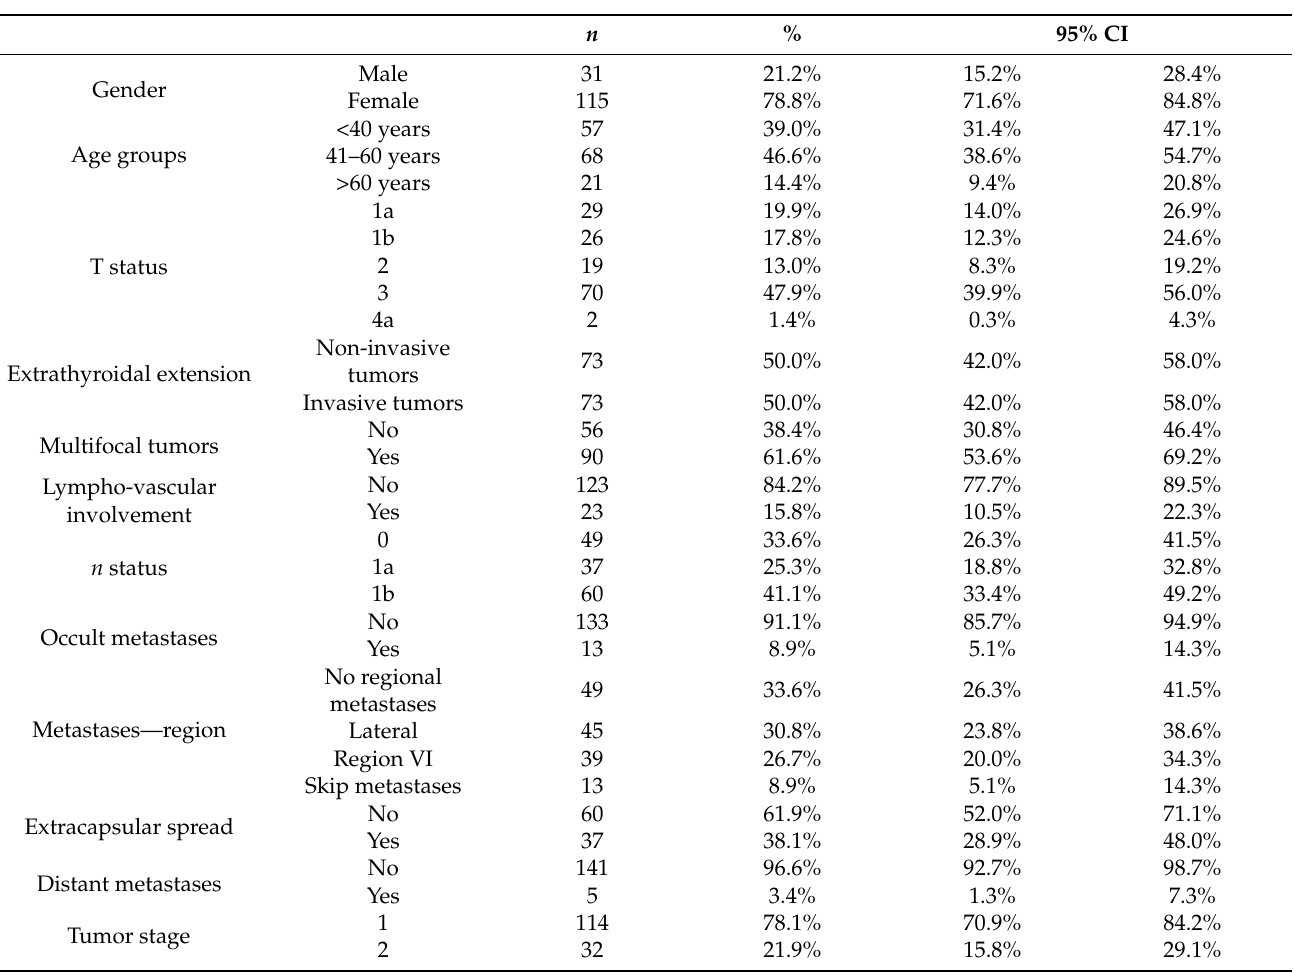
Table 1. Descriptive statistics of clinical and pathological features of PTC among included subjects at the time of diagnosis (Total n =